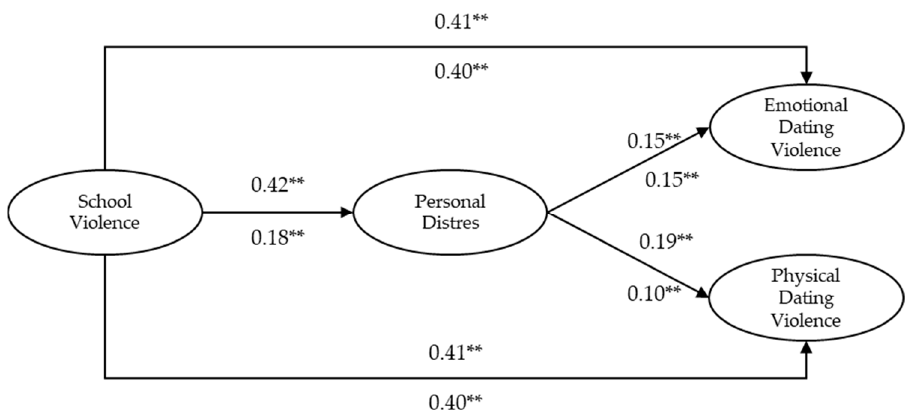
Figure 1. Unconstrained A-B-C model with path coefficients and statistical significance. ** p < 0.01. β values for boys are above the path and β values for girls are below the path.